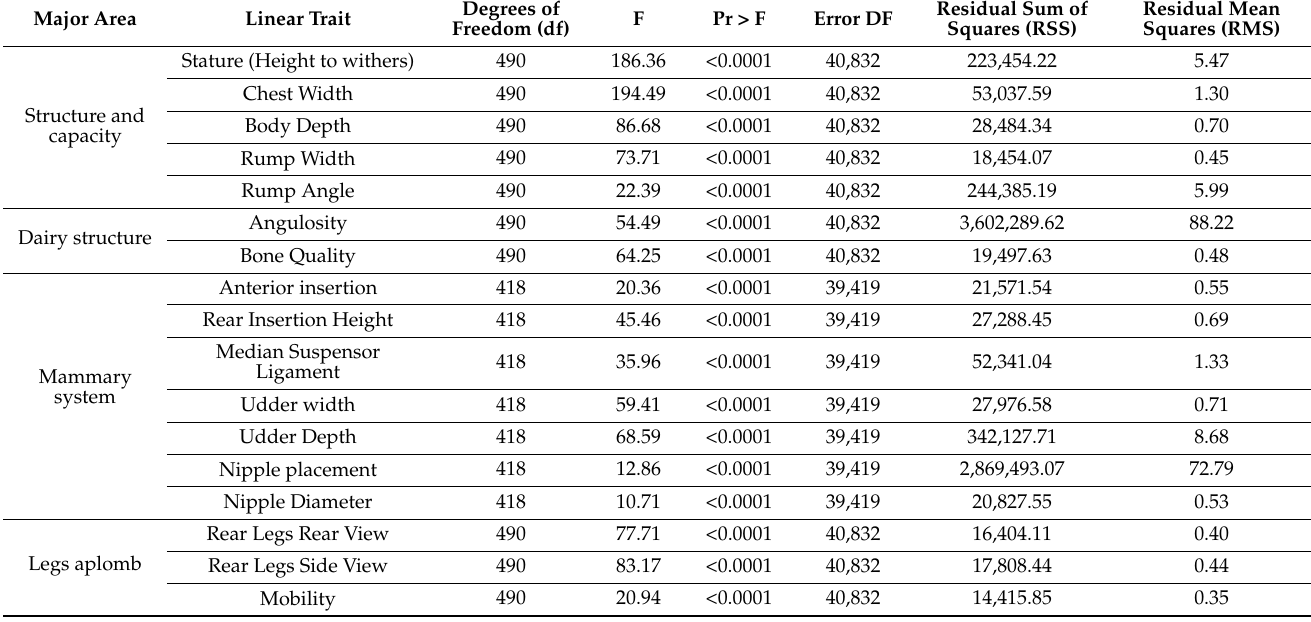
Table 2. Type III Sum of Squares analysis for zoometric traits to LAS scores in Murciano-Granadina primipara and multipara does (41,323) and bucks